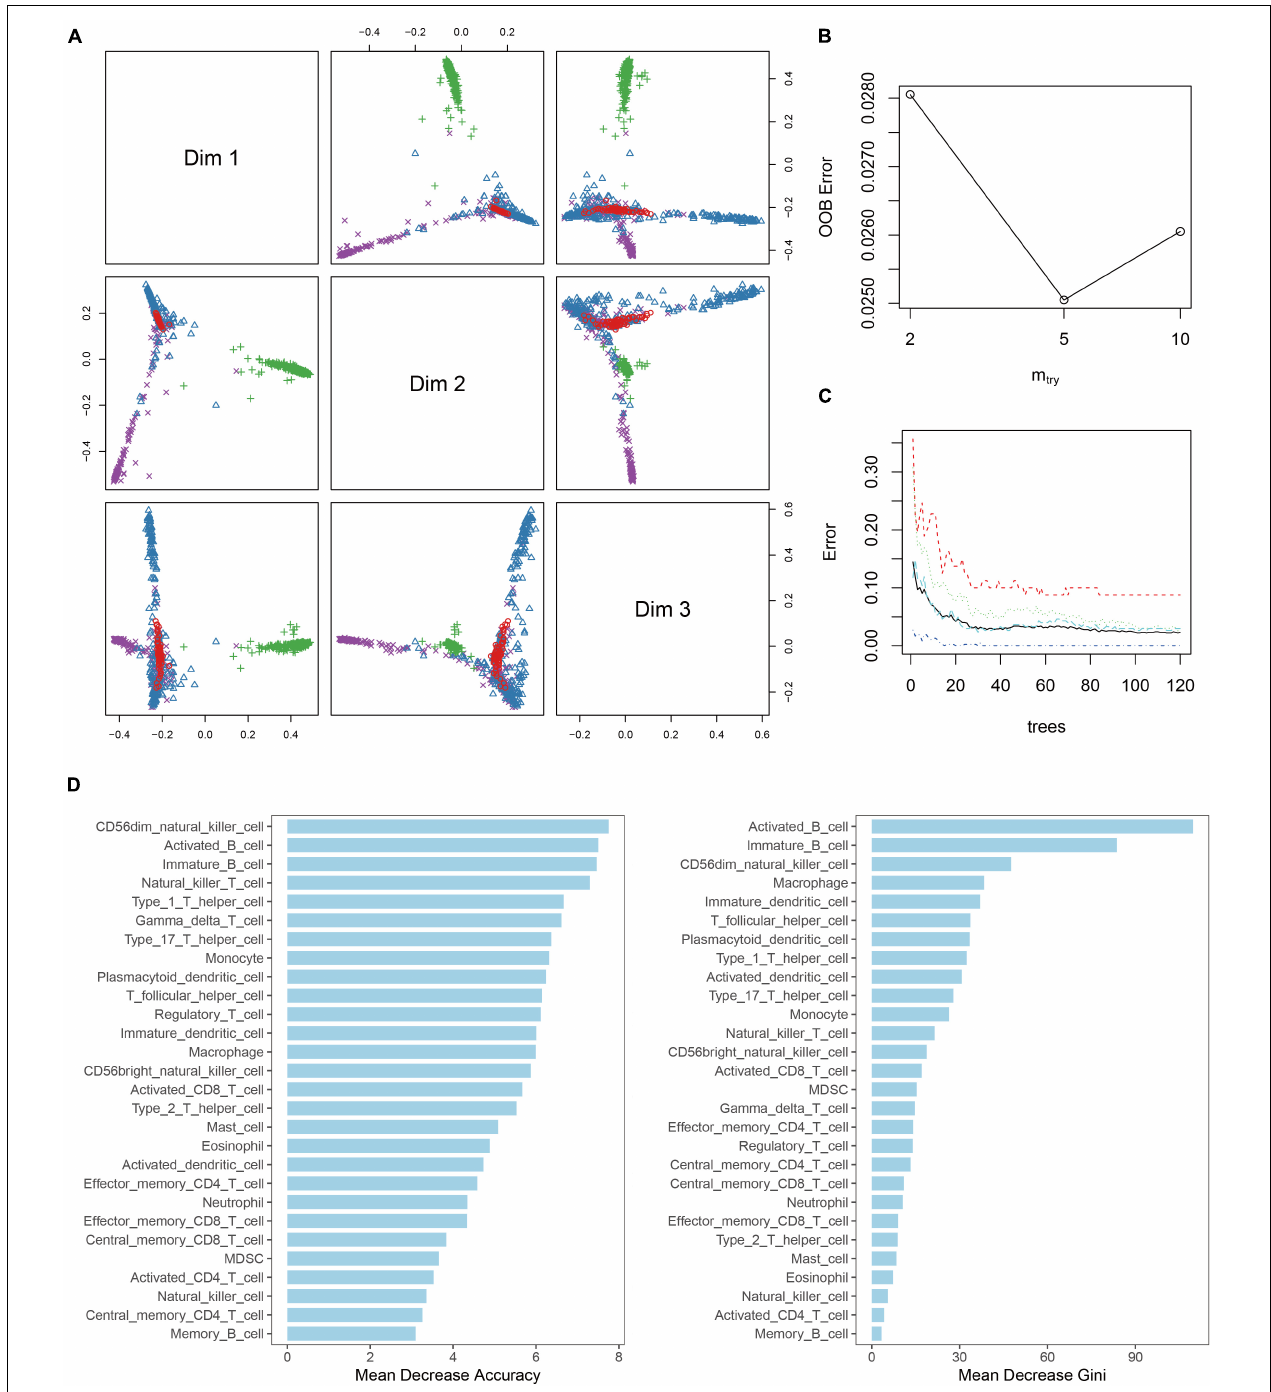
FIGURE 3 | Random forest diagnostic model. (A) MDS plot shows the three-dimensional distances between different disease. (B) Line plot shows the out-of-bag error (OOB error) of the model with “mtry” parameter setting at 2, 5, and 10. (C) Line plot shows the stability of the model with different “tree” parameter settings. (D) Histogram of the importance of each ES score in the model.